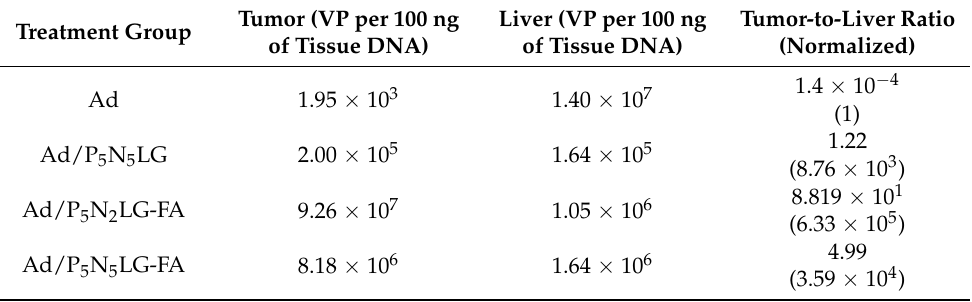
Table 2. Tumor-to-liver ratio of systemically administered Ad nanocomplexes. The tumor-to-liver ratio, which is an important parameter determining safety and therapeutic efficacy of systemically ad- ministered adenovirus, of different treatments. The values within parentheses have been normalized to naked Ad-treated